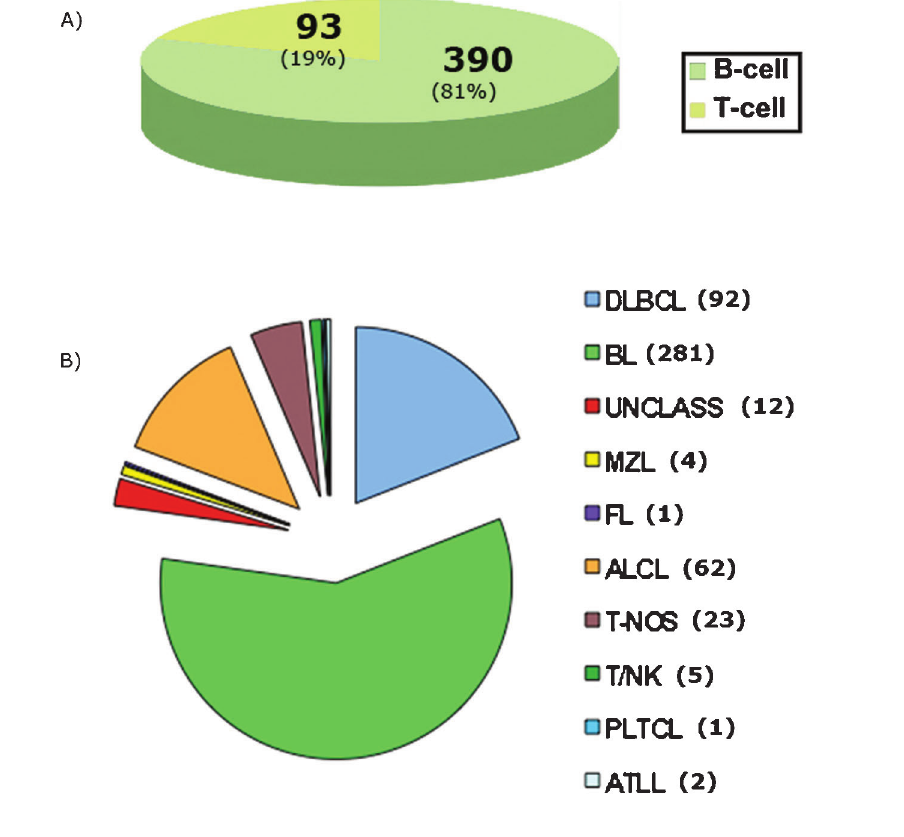
Figure 2 - Pediatric mature non-Hodgkin lymphoid neoplasm. A, Global distribution according to cell lineage. B, Specific distribution according to main subtypes.